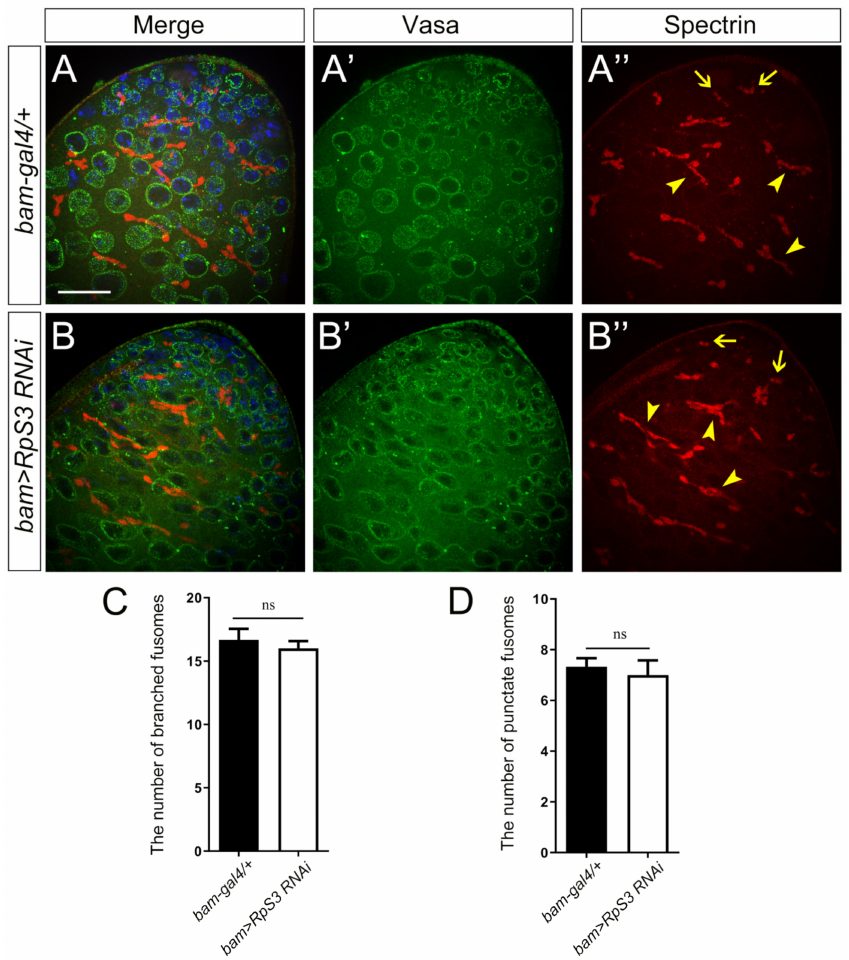
Figure 3. The early spermatogenesis was not affected by RpS3 knockdown. ( A , B ) The immunofluores- cent staining using the markers for early spermatogenesis in control testis ( A ) and RpS3 -knockdown testis ( B ). Vasa is a pan-marker for germ cells ( A’ , B’ ). The antibody against α -spectrin labels the fusomes ( A” , B” ), which exhibited two shapes: the round fusomes (indicated by arrows) and branched fusomes (arrowheads). DNA was stained with DAPI (blue). Scale bar: 25 µ m. ( C , D ) The number of punctate fusomes ( C ) or branched fusomes ( D ) at the apex of bam-gal4/+ ( n = 11) and bam>RpS3 RNAi ( n = 8) testes was quantified. ns, not